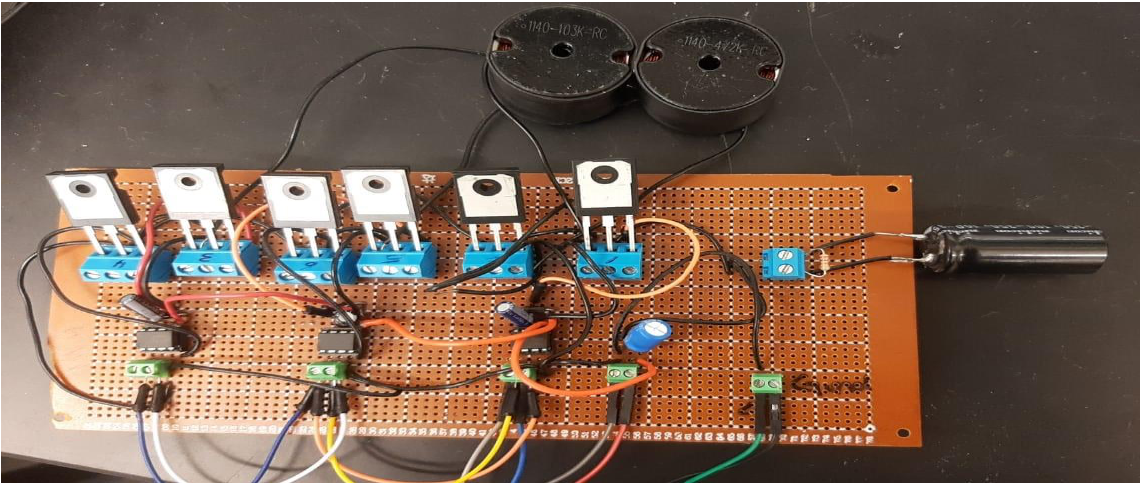
Figure 17. Multi input converter prototype. Table 10. Design specification of the multi-input converter prototype.